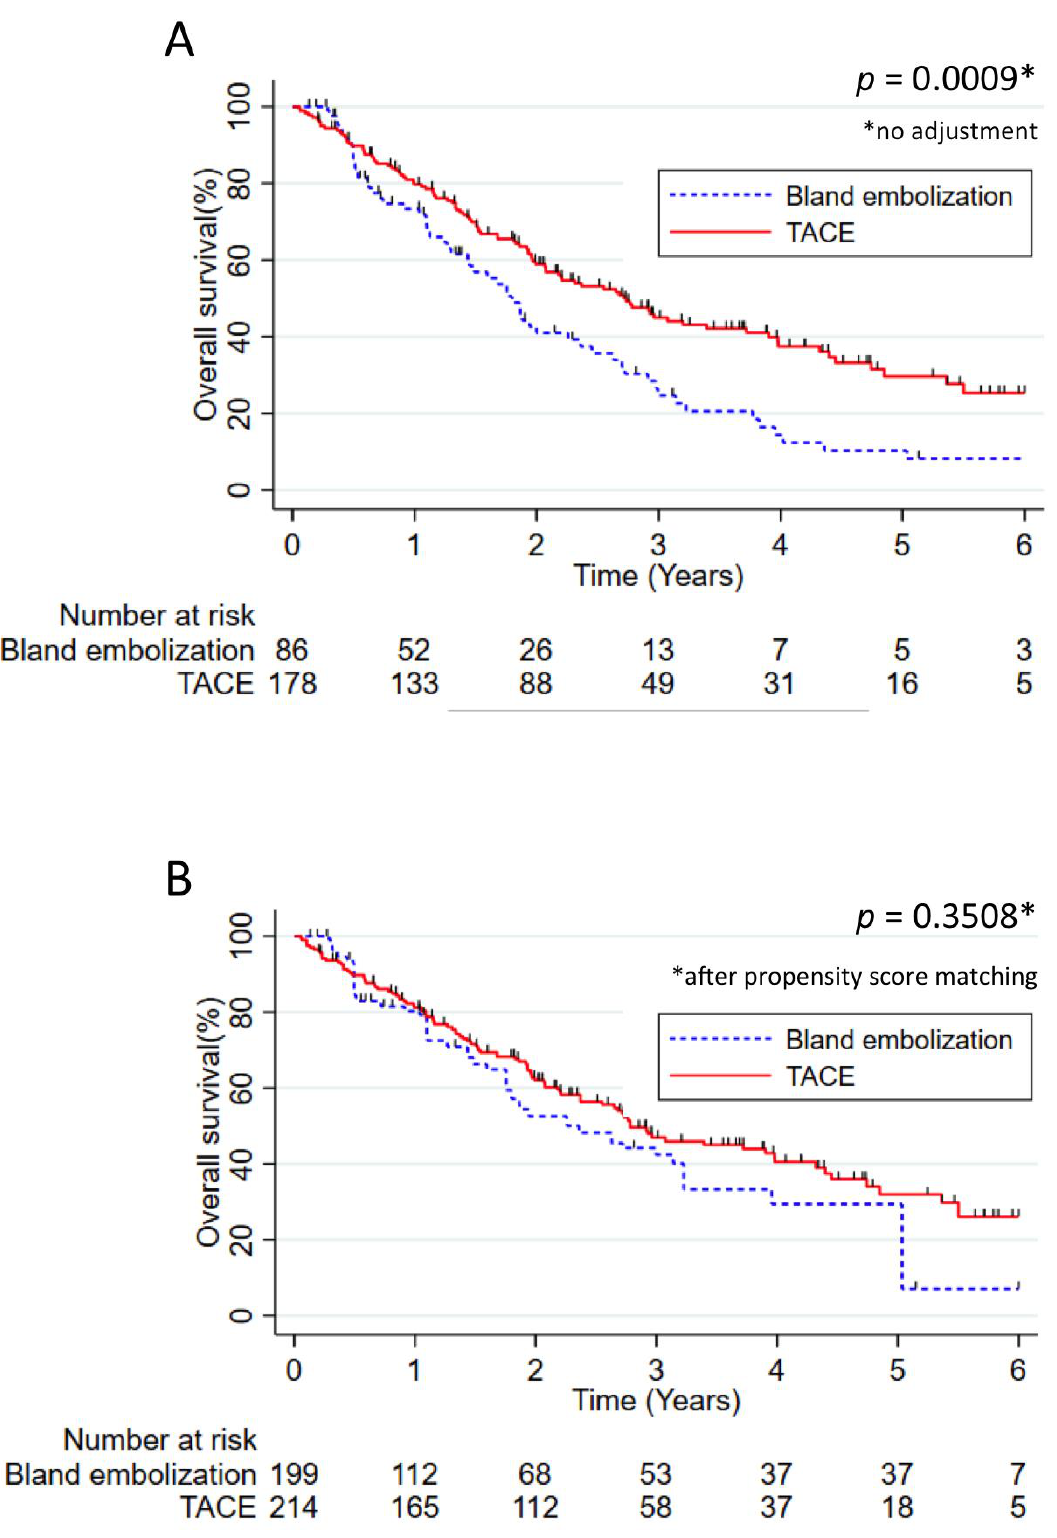
Figure 3. Overall survival in patients treated by TACE versus patients treated by TAE. ( A ) Overall survival without adjustment and ( B ) overall survival adjusted using the propensity score. The results were analyzed using the Kaplan–Meier method and compared using the log rank test. Numbers at risk were reported under the x -axis.